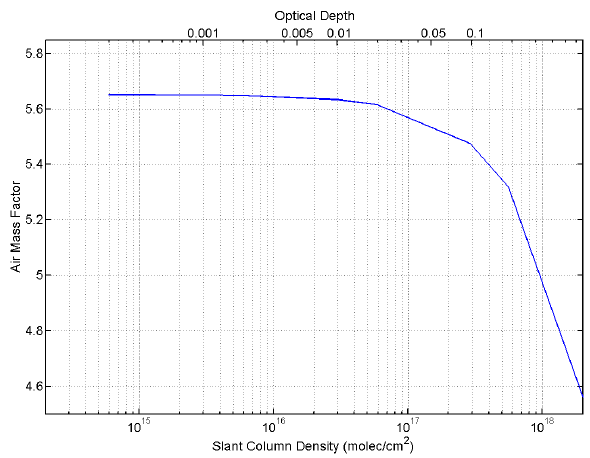
Fig. 7. Air mass factor versus surface visibility (red), albedo (blue) and pitch angle (black). The last two parameters only have small effects due to the limb observation geometry and the large field of view, respectively. The calculations were done at 460nm for an al- titude of 0.5km, setting a relative azimuth and solar zenith angle of 90 ◦ and 45 ◦ , respectively, and with a 1km thick homogeneous boundary layer.